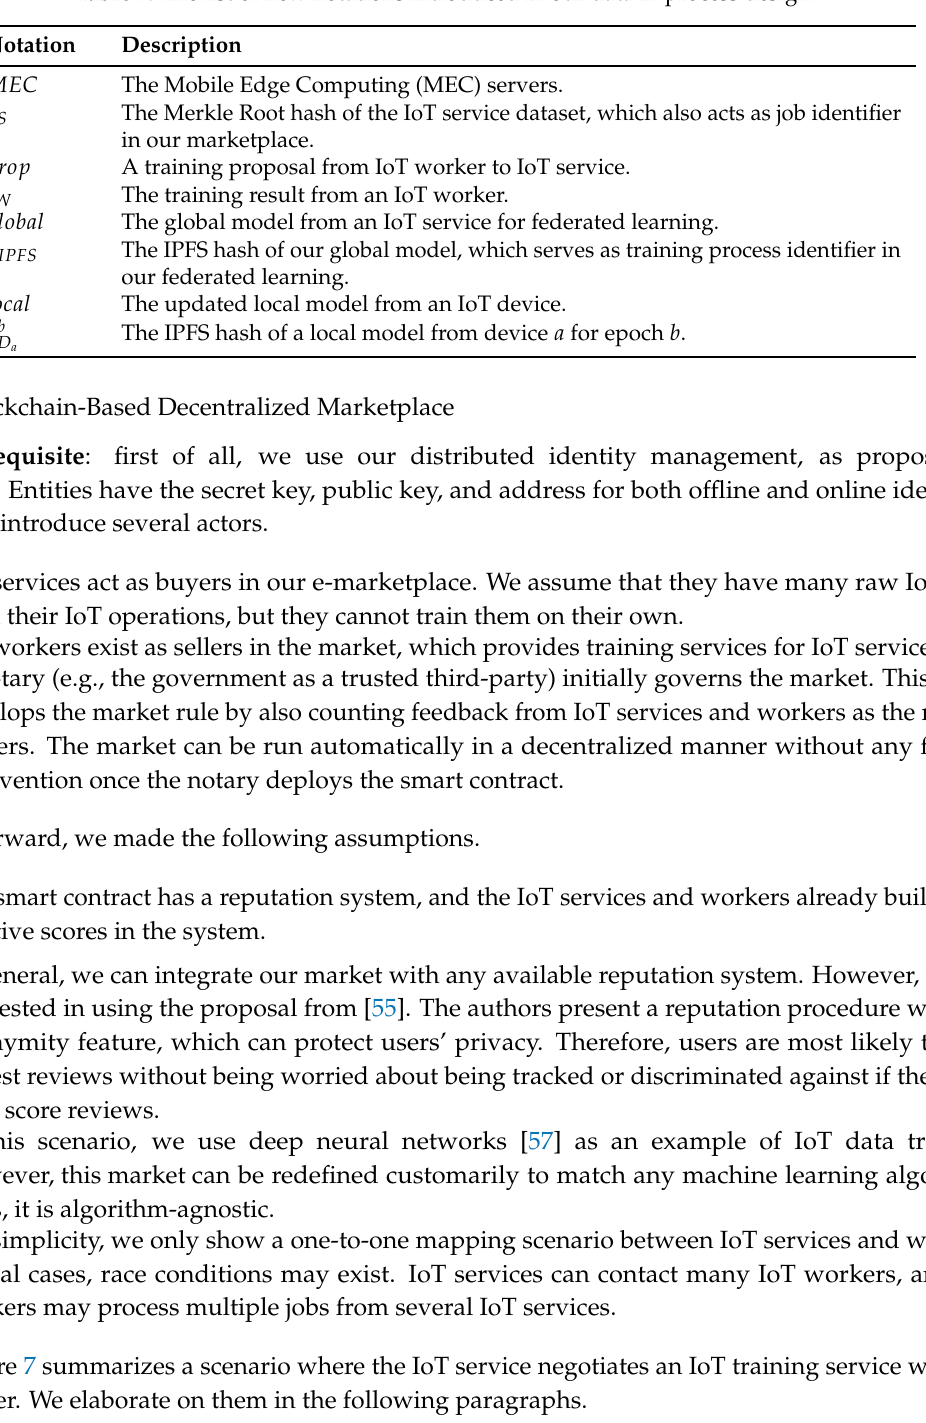
Table 7. The list of new notations introduced in our data in process